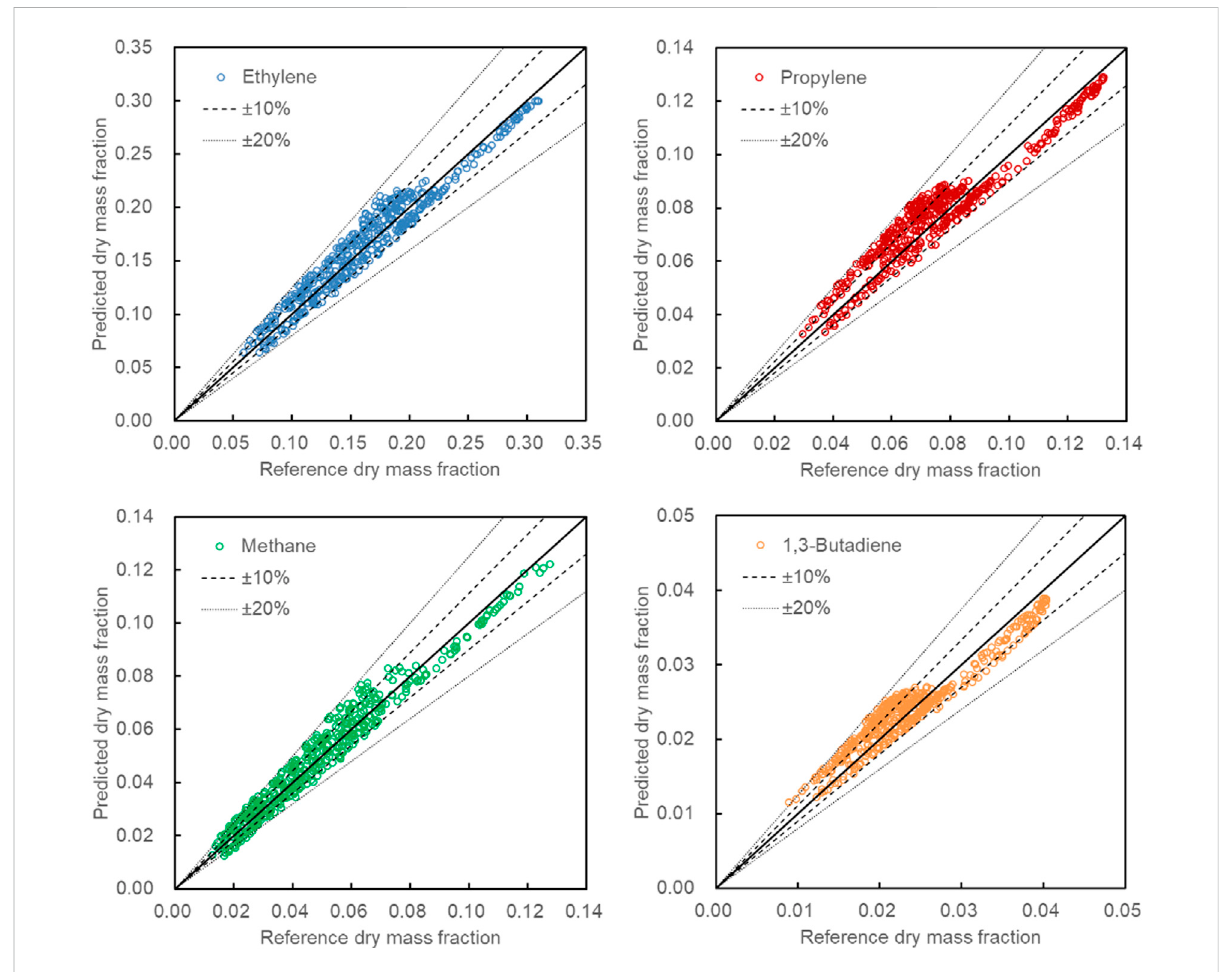
FIGURE 9 Predicted results of four selected products for 472 test sets: ethylene, propylene, methane, 1,3-butadiene.